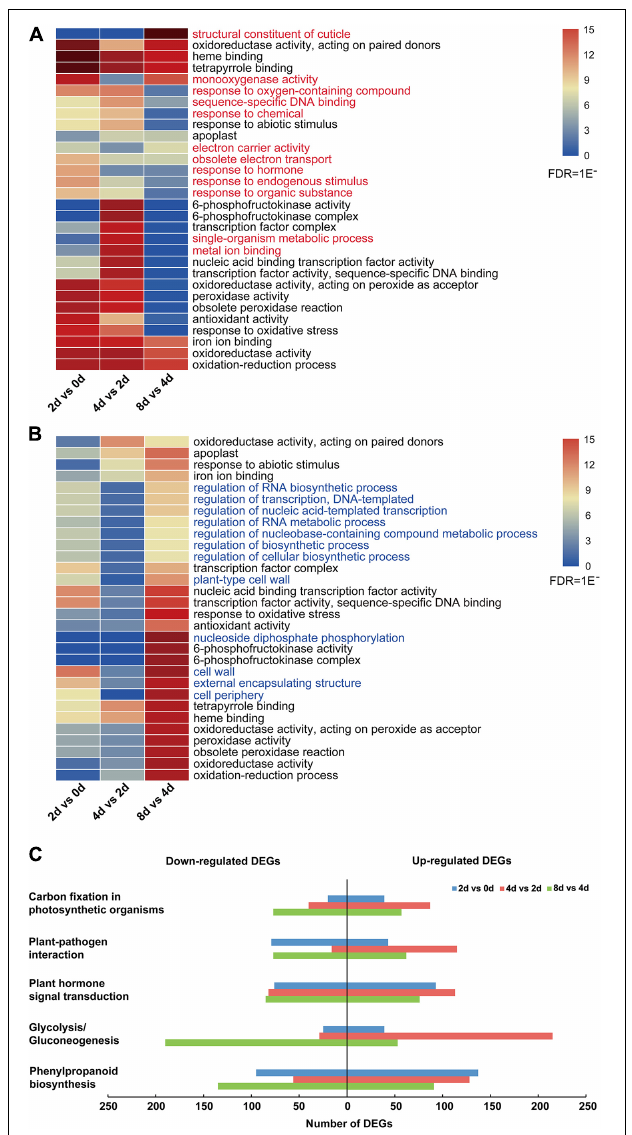
FIGURE 3 | DEG analysis of centipedegrass nodal root development stages. (A) Top 30 enriched GO terms of all upregulated DEGs. (B) Top 30 enriched GO terms of all downregulated DEGs. (C) Number of upregulated and downregulated DEGs enriched in five KEGG